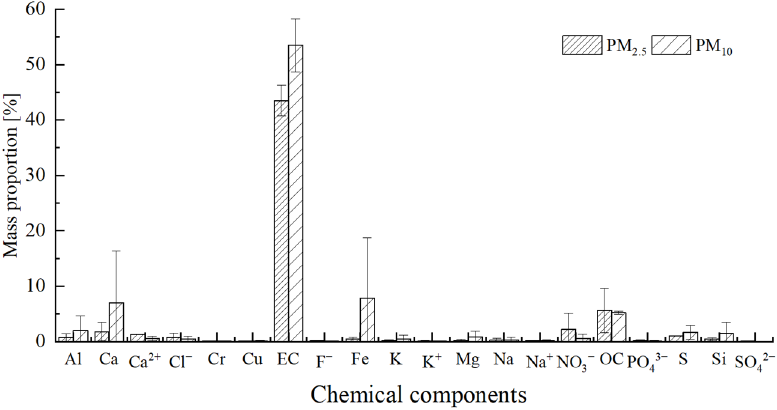
Figure 1. The mass proportions of major chemical components in PM 10 and PM 2 . 5 from carbon plant.